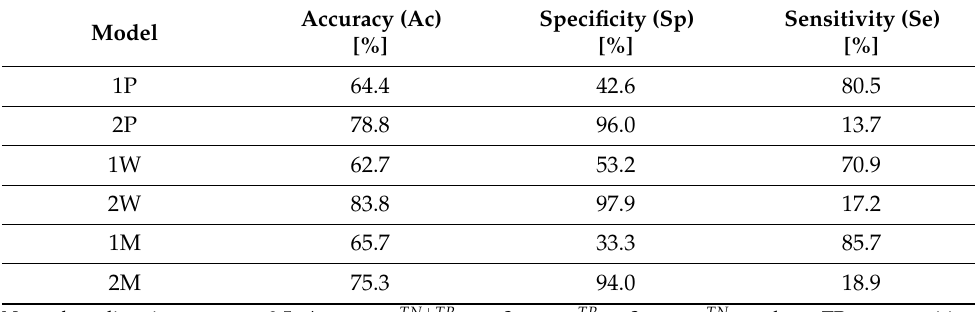
Table A5. Accuracy, Sensitivity and Specificity of the Models.